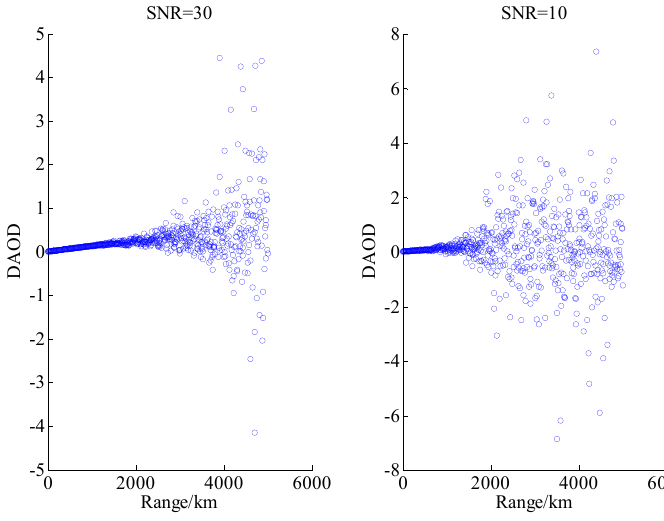
Figure 9. DAOD of DW-DIAL with SNRs of 30 and 10.